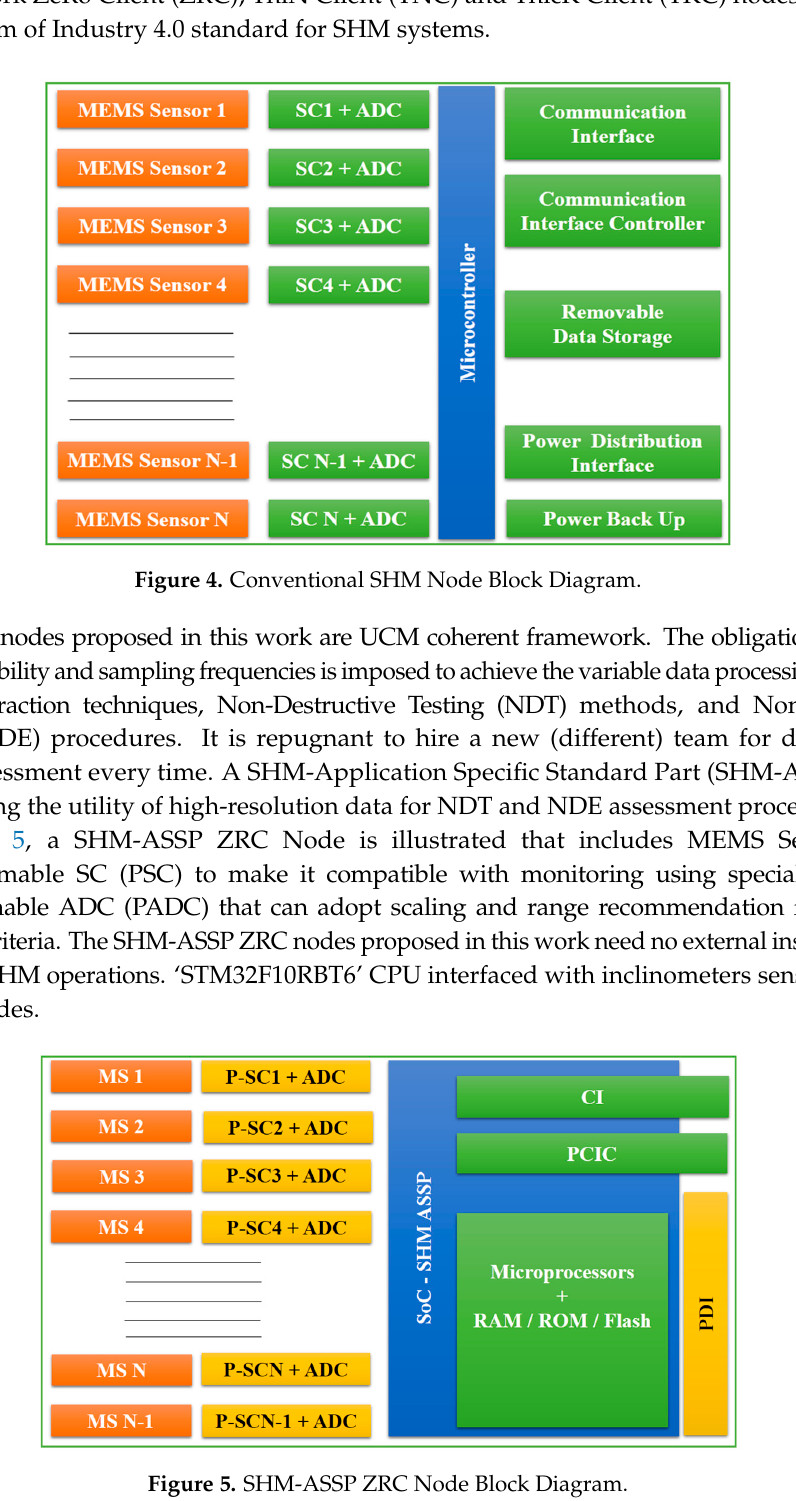
( b ) Figure 6. SHM ‐ ASSP ZRC Nodes. ( a ) SSN. ( b ) CSN. It is noteworthy to highlight that these nodes are enhanced with remotely programmable and configurable parameters. Figure 7 shows an OSB that has a micro expert system with multiple resource ‐ constrained Machine Learning SHM Algorithm.